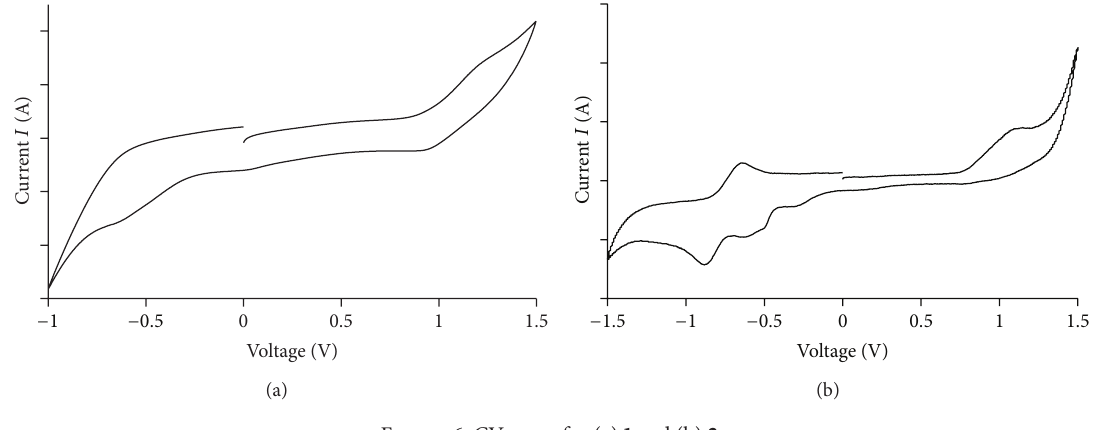
Figure 6: CV scans for (a) 1 and (b) 2